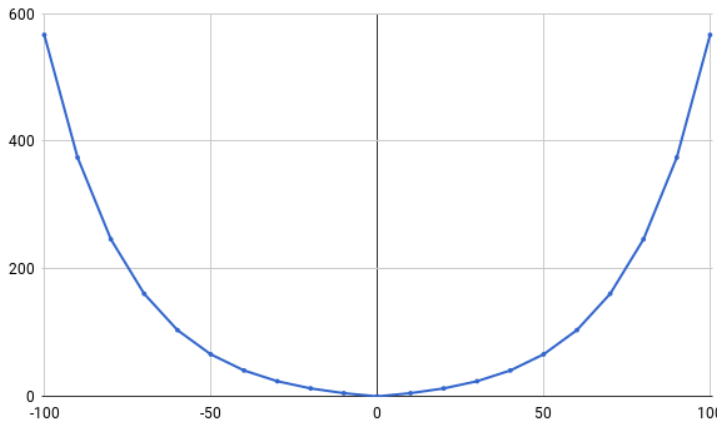
Figure 2. Piece-Wise Linear Cost Function. The abscissa represent the percentage of upward and downward capacity and the ordinates represent the percentage cost of